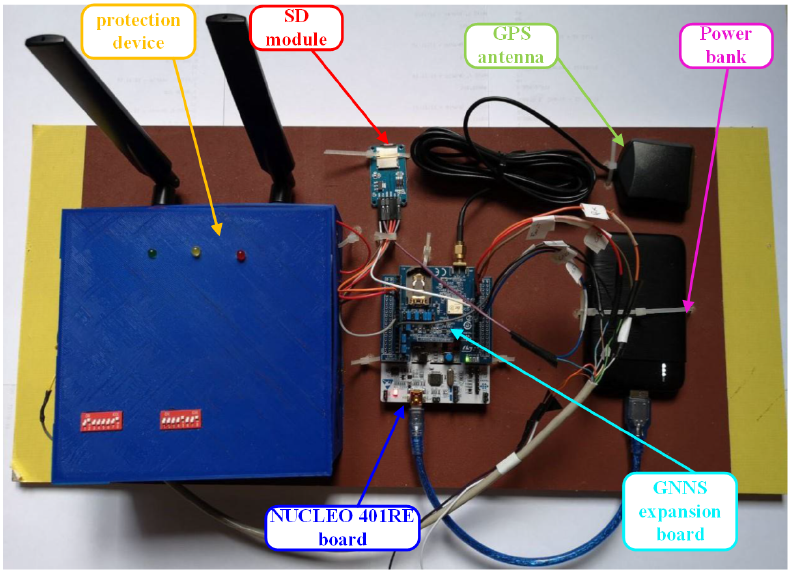
Figure 7. Protection device and control node assembled for field